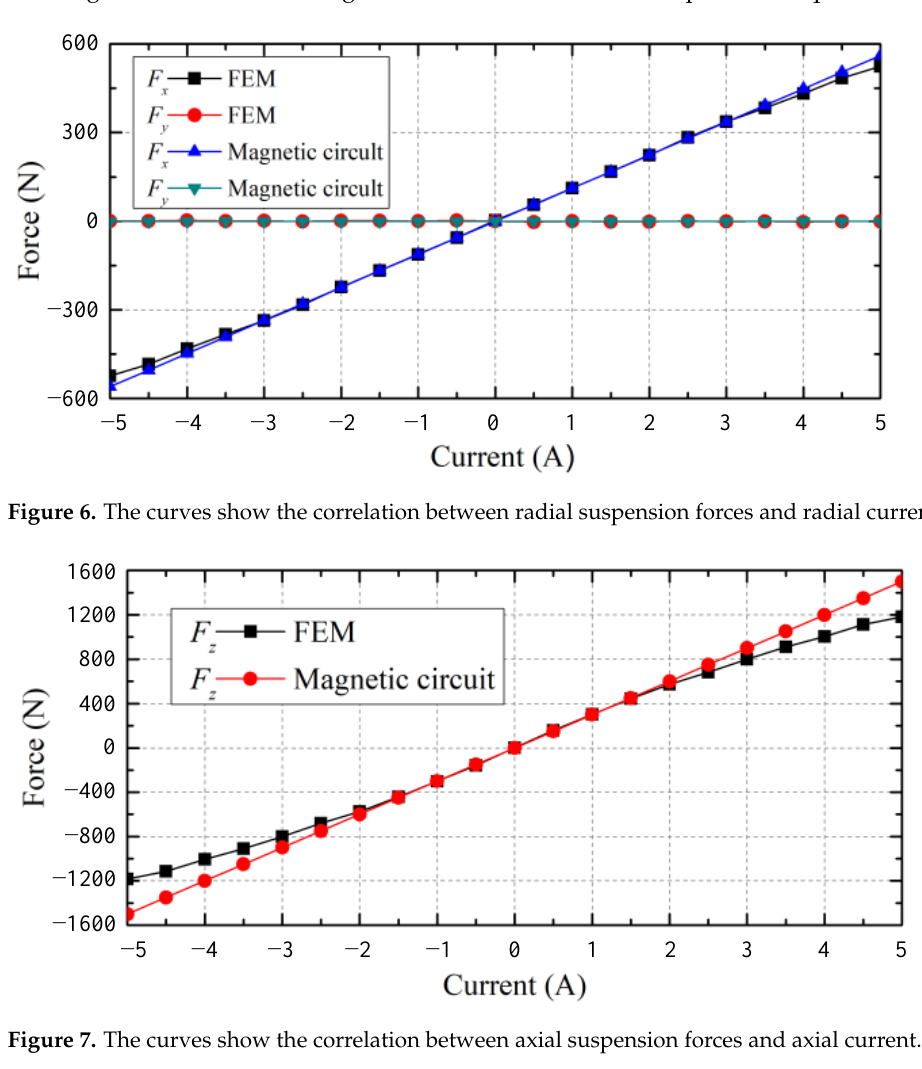
current was small, the axial suspension force was linear with the axial current, and the FEM analysis result was consistent with the theoretical result. With the increase in the axial current, the axial force of the FEM was less than that of the equivalent magnetic circuit due to the magnetic saturation. Therefore, the linearity and consistency were ideal when working in a small current range, which can meet the actual operation requirements.